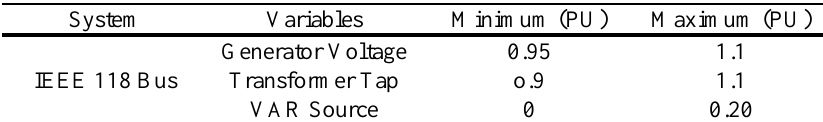
Table 10. Constraints of control variables.